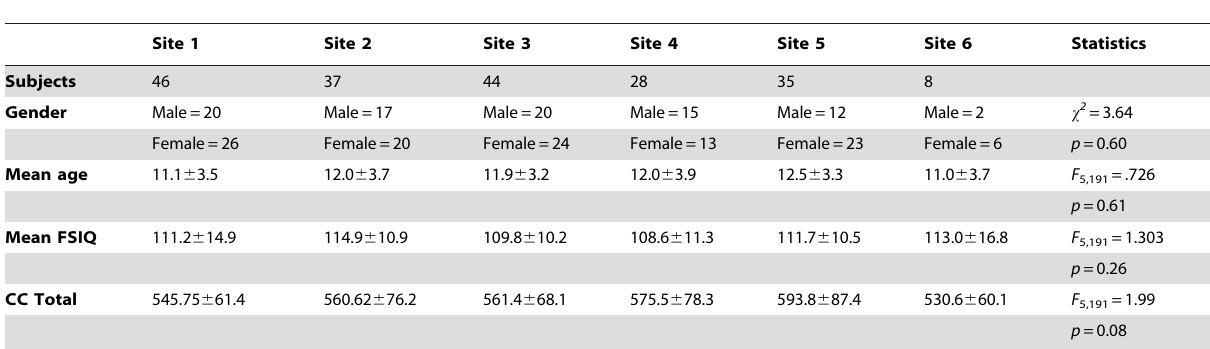
Table 2. Balance of subjects and demographic characteristics from each study site.